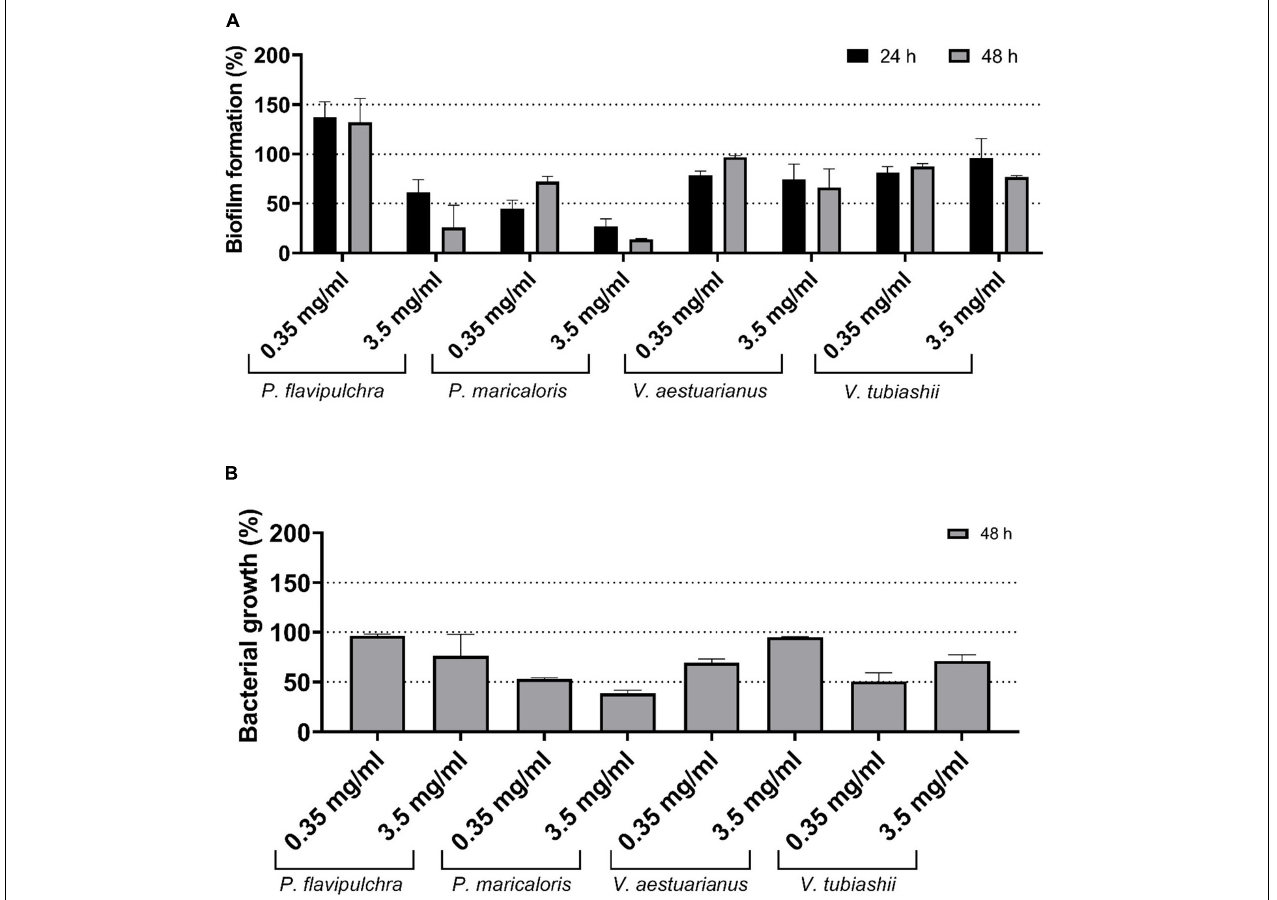
FIGURE 1 | Effect of the methanol cell extract (MCE) of Bacillus licheniformis NCTC 10341 T at final concentration of 0.35 and 3.5 mg/ml on biofilm formation (A) and planktonic growth (B) of the biofilm-forming marine bacteria Pseudoalteromonas flavipulchra , Pseudoalteromonas maricaloris , Vibrio aestuarianus, and Vibrio tubiashii . Biofilms were incubated for 24 h (black) and 48 h (gray) and measured with the xCELLigence real-time monitoring system. Planktonic growth was measured as optical density at 600 nm of homogenized cultures after 48 h. Values are shown as percentage in comparison with untreated controls ( n =